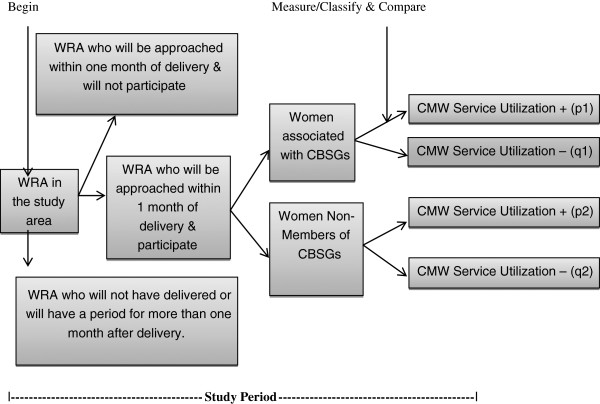
Flow chart of study.